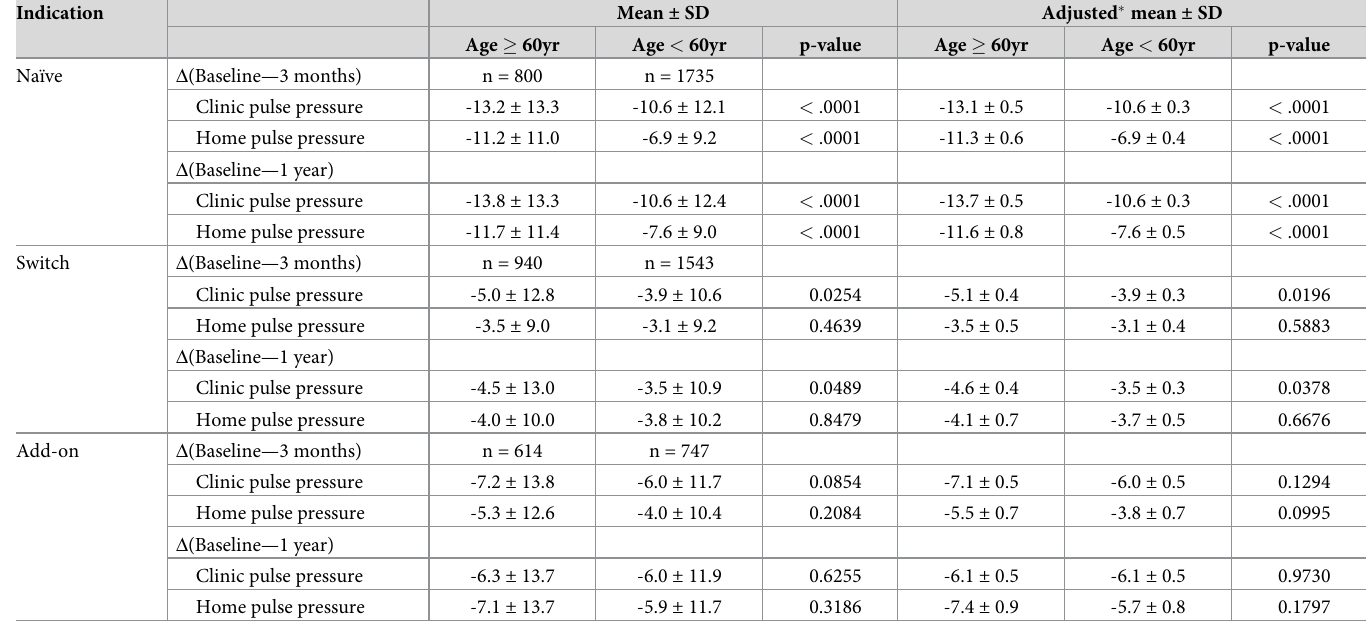
Table 3. Decrease in pulse pressure for 1 year after adjustment by indication